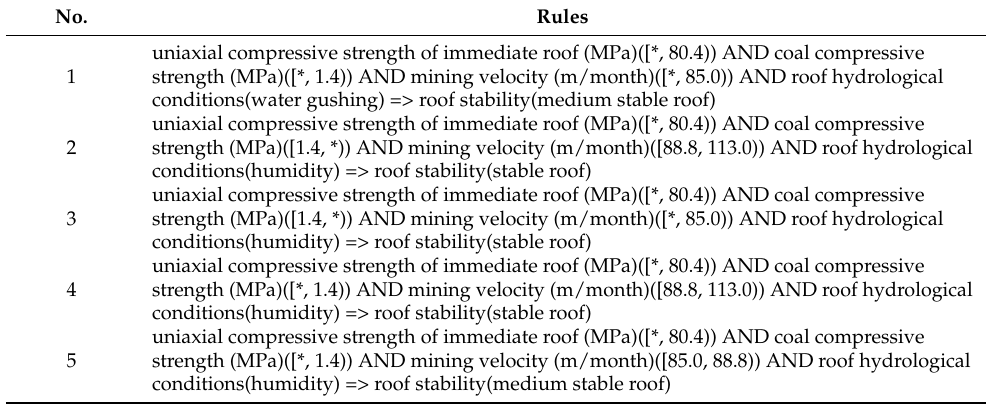
Table 5. Partial inference rules about coal mine roof